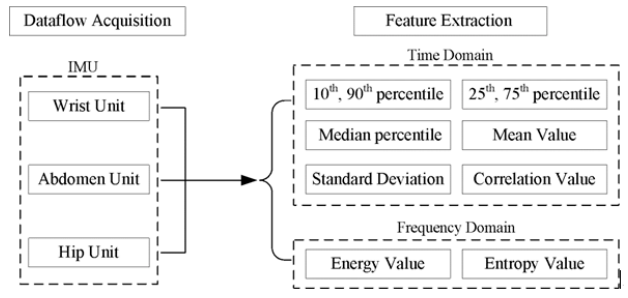
Figure 5. Description of the recognition feature extracted.